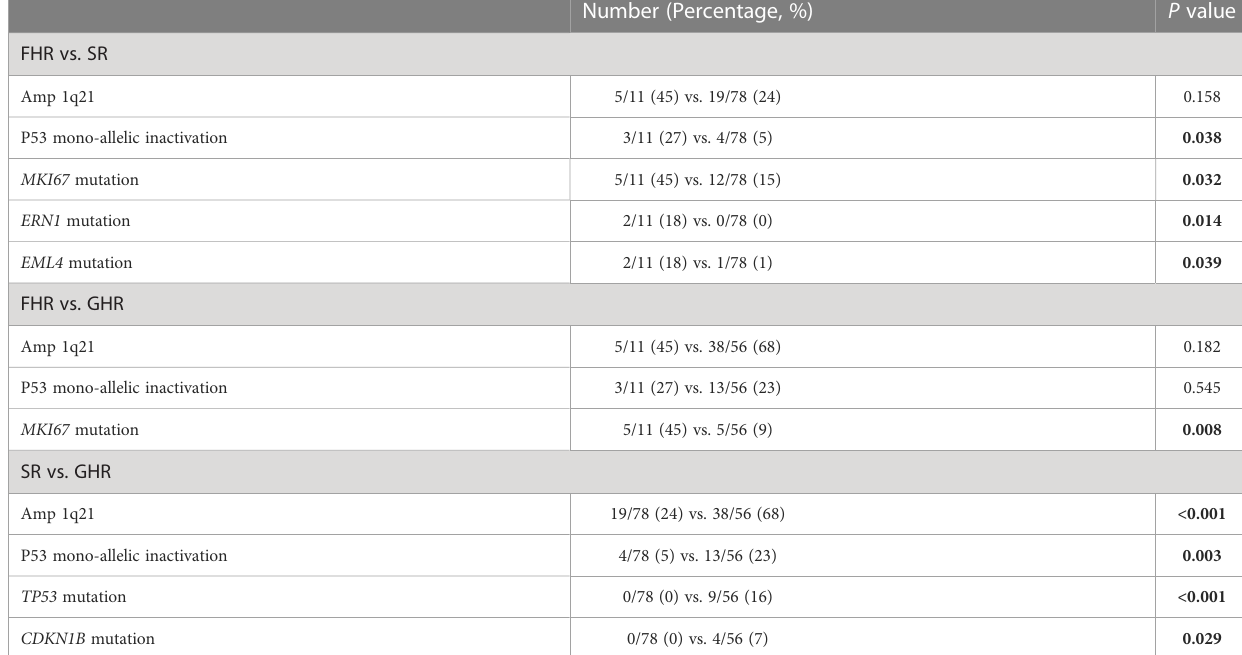
TABLE 2 Subgroup analysis of genetic abnormalities.